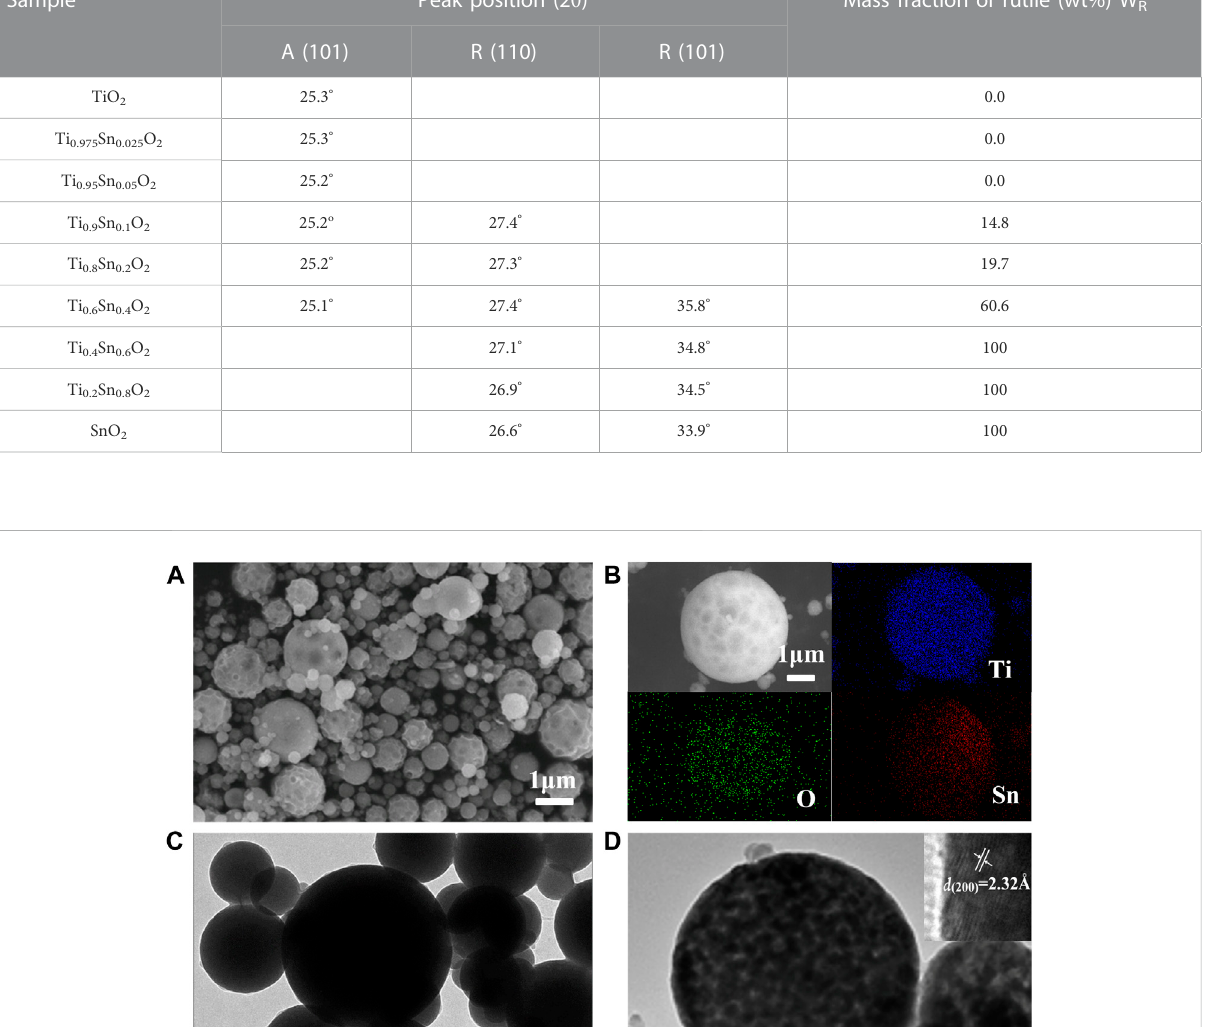
0.8 Sn 0.2 O 2 solid-solution after sintering at 550 ° C for 3